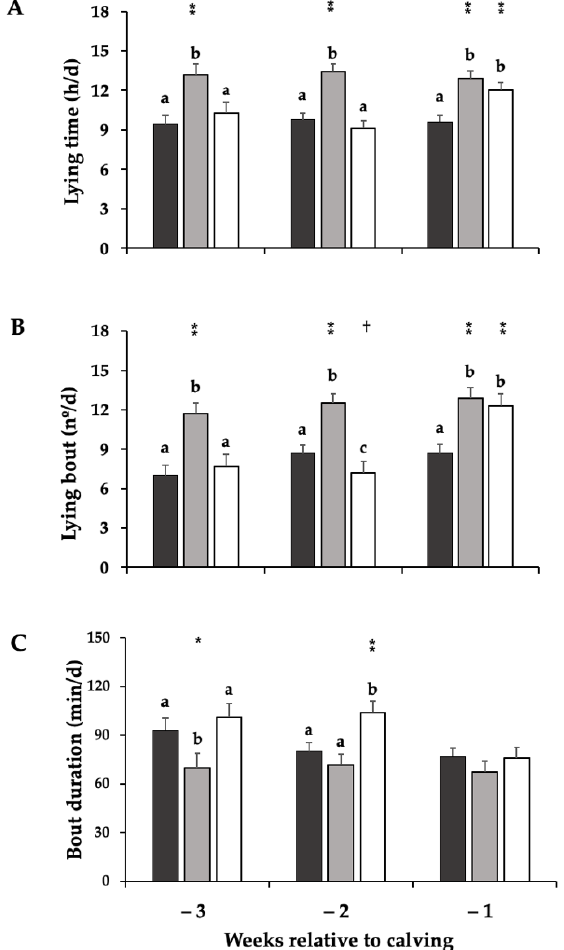
Figure 2. Lying time ( A ), lying bouts ( B ) and lying bout duration ( C ) of dairy cows kept in an outdoor paddock from 3 weeks before calving until calving day (black bar), or subjected to an early (3 weeks before calving; gray bar) or late movement (1 week before calving; white bar) to an indoor maternity pen where they remained until calving day ( n : 13 cows per treatment). Least squares means and SE are reported. Different letters (a, b, c) indicate a statistical difference in the same week. † p < 0.10, * p < 0.05, ** p < 0.001. Cows in OP and LM had lesser lying bouts compared with EM during week − 3 and − 2 before calving (week − 3 = 7.0 ± 0.8, 7.7 ± 0.9, and 11.7 ± 0.8; week − 2 = 8.7 ± 0.6, 7.2 ± 0.9, and 12.5 ± 0.7 bouts/d, respectively; p < 0.001; Figure 2B). We observed that for OP cows the number of lying bouts decreased in week − 1 compared to LM (8.7 ± 0.7 vs. 12.3 ± 0.9 bouts/d; p < 0.001); this difference was no longer evident with EM cows (12.3 ± 0.9 vs. 12.9 ± 0.8 bouts/d; p > 0.1). Mean lying bout duration was longer in OP and LM cows than EM cows during week − 3 and − 2 (week − 3 = 93.0 ± 7.4, 101.3 ± 8.5, and 69.9 ± 9.0; week − 2 = 80.3 ± 5.4, 104.0 ± 7.1, and 71.8 ± 6.4 min/d, respectively; p < 0.05; Figure 2C). During the week before calving, we did not observed differences among treatments (OP = 76.8 ± 5.5, EM = 67.7 ± 6.6, and LM = 76.0 ± 6.7; p > 0.1). Cows in OP had a lower daily rumination time compared to EM cows on week − 2 (546 ± 16 min/d vs. 584 ± 18; p < 0.05) and to LM cows on week − 1 (536 ± 16 min/d vs. 575 ± 19; p < 0.05; Figure